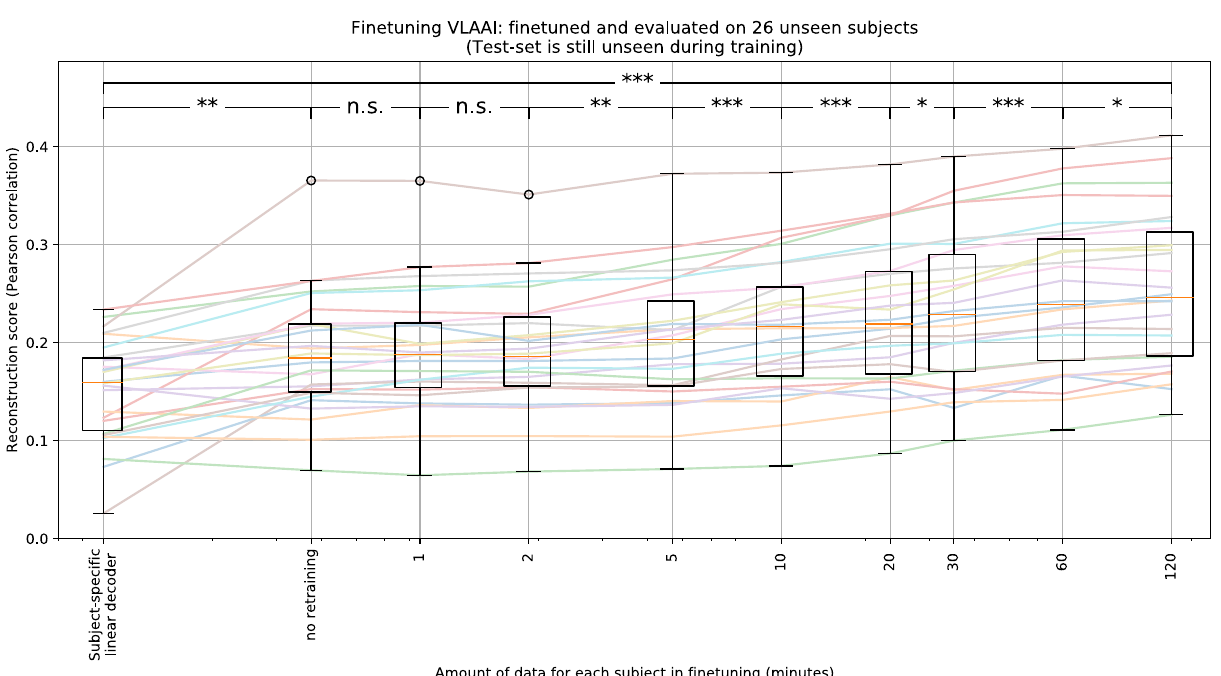
Figure 7. Subject-independent VLAAI, trained on the single-speaker stories dataset, finetuned on the subjects of the holdout dataset. Each point in the boxplot is the reconstruction score for a subject, averaged across stimuli. No significant increase is found between the subject-independent model (no finetuning) and models finetuned with 1 and 2 minutes of data. Starting with 5 minutes of available finetuning data, the median reconstruction score seems to increase logarithmically from 0.19 with the amount of training data to 0.25 Pearson r for 120 minutes. (n.s.: p ≥ 0.05, *: 0.01 ≤ p < 0.05, **: 0.001 ≤ p < 0.01, ***: p <